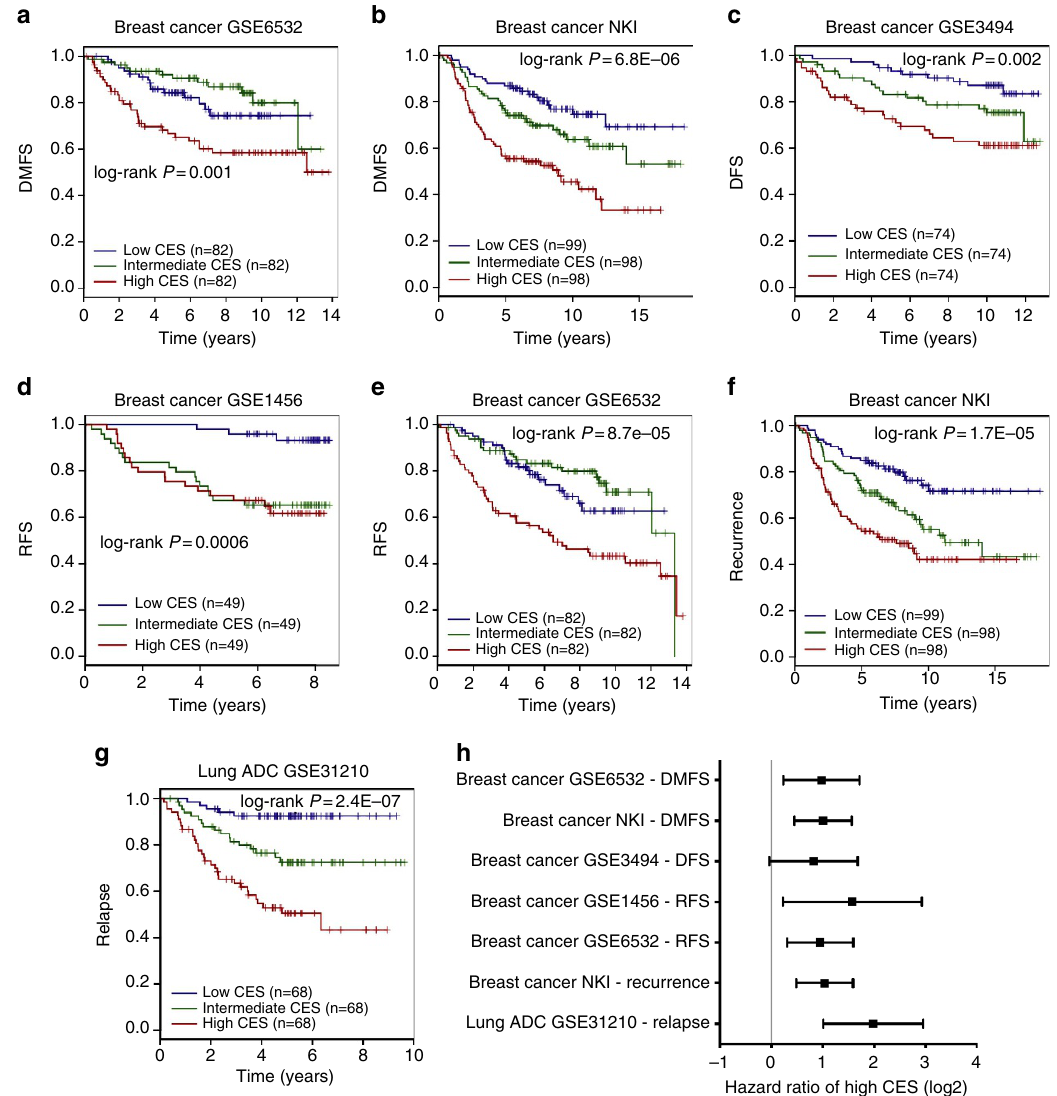
Figure 4 | CES signature is prognostic for cancer patient risk of relapse and metastasis. ( a – g ) Kaplan–Meier survival estimations for individual breast cancer and lung cancer data sets for distant metastasis-free survival (DMFS), relapse-free survival (RFS)/disease-free survival (DFS) and relapse/recurrence. Each cohort was divided into CES high (red), intermediate (blue) and low (green) tertiles. Sample sizes and log-rank P values are indicated. ( h ) Forest plot summarizing prognostic impact of CES on DMFS, RFS/DFS and relapse/recurrence by multivariate Cox regression using individual data sets. Squares and error bars in the plots denote log2 scales of hazard ratio (HR) and 95% confidence interval (CI), respectively. See details of multivariate Cox regression analysis